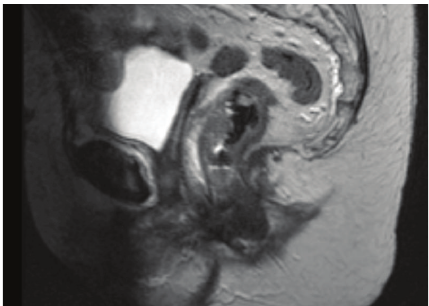
Figure 3: Sarcomatous component visible on HPE.